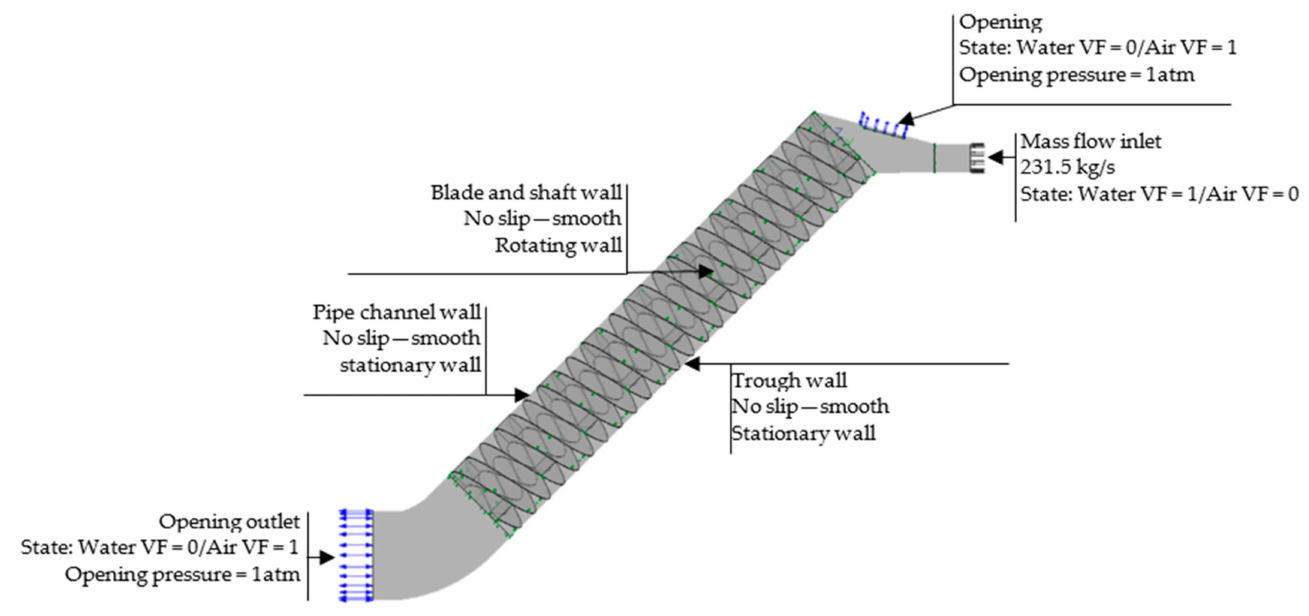
Figure 6. CFD setup for AST using Ansys CFX 19.2 version.